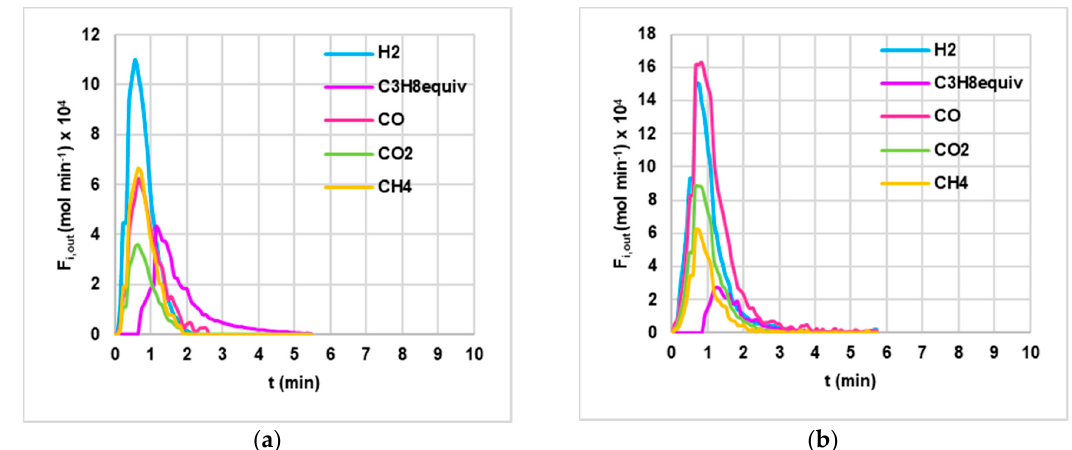
Figure 4. Example of H 2 , CO, CO 2 , CH 4 and equivalent C 3 H 8 outlet molar flow rates ( F i,out ) as functions of time ( t ), pro- duced by devolatilizations of AHPam ( a ) and AHPus ( b ), in the sand fluidized bed, at 800 °C, under nitrogen atmos- phere.